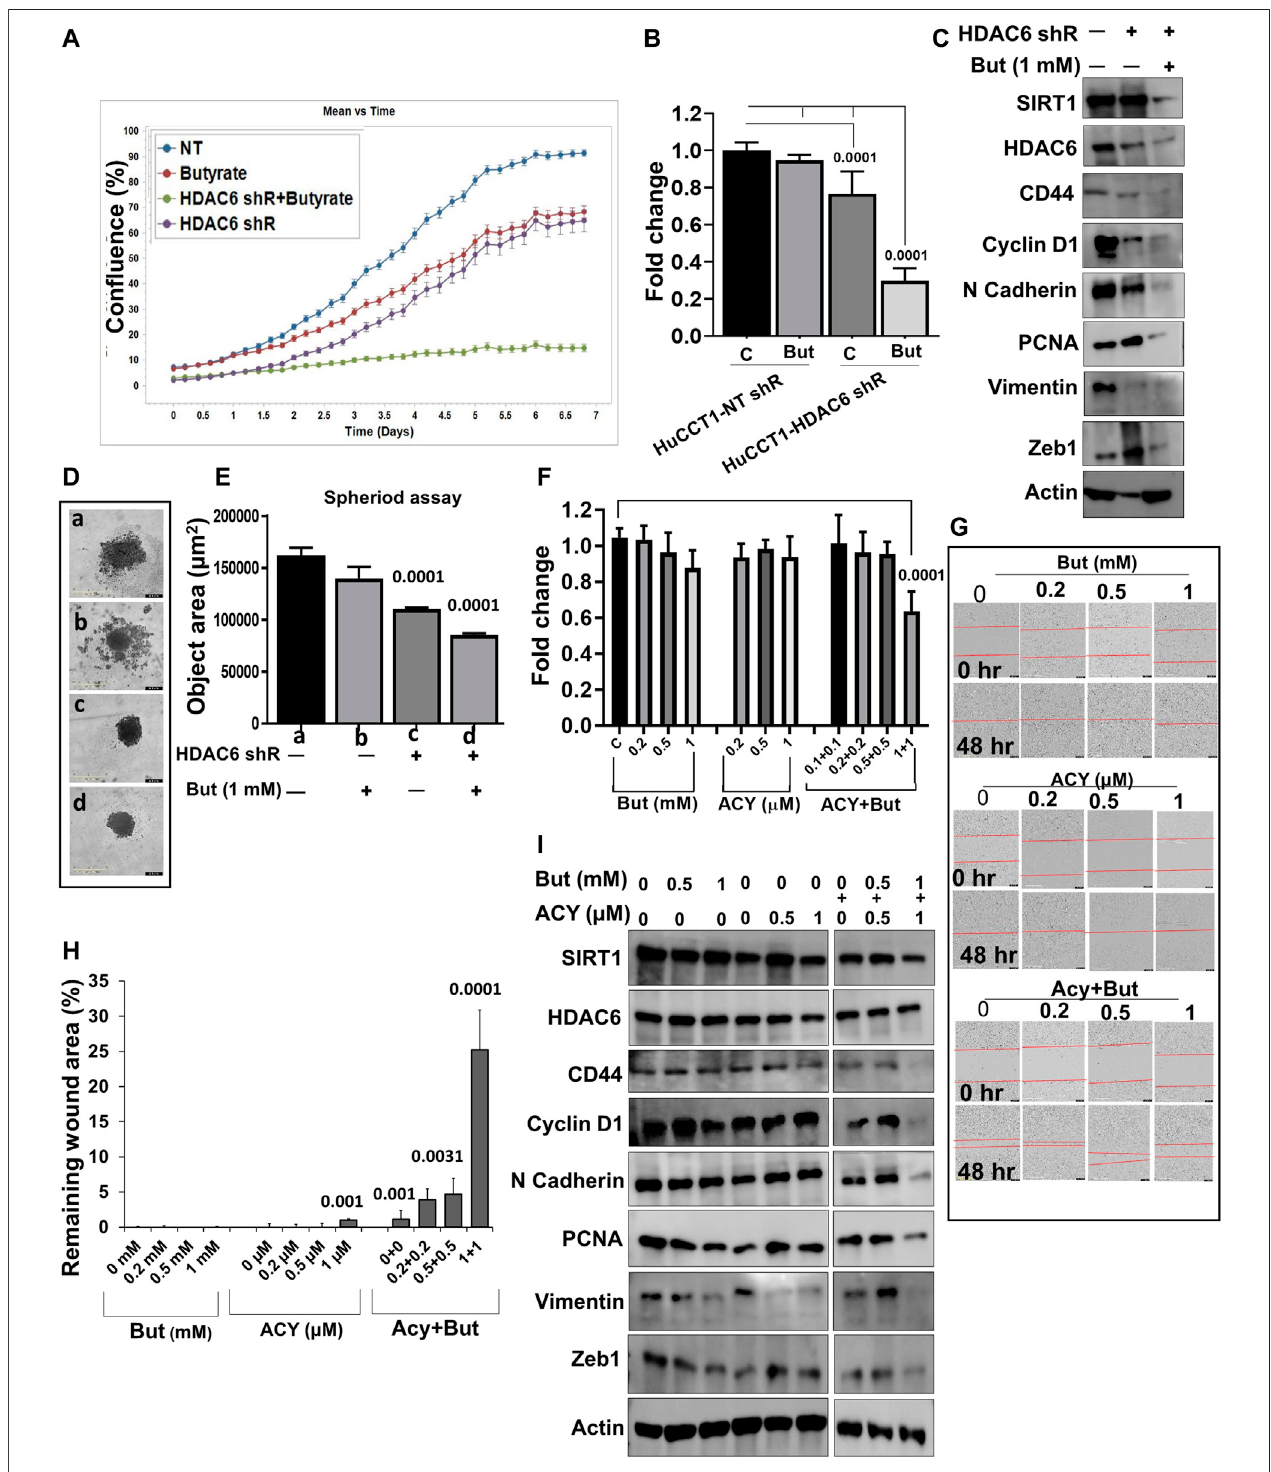
FIGURE3| ButyratepotentiatestheeffectoftheHDAC6inhibitors. (A) IncyCytecellproliferationassaywasdoneinHuCCT1cellstransfectedwithHDAC6shRNA andbutyrate(1 mM),andnon-targetshRNAwasusedasacontrol. (B) MTScellgrowthassaywasdoneinHuCCT1-HDAC6shRNAaloneorinthepresenceofbutyrate (1 mM). (C) Total cellular protein was isolated from HuCCT1 (NT, HDAC6-shR and HDAC6-shR + butyrate) cells and Western blots were performed for SIRT1, HDAC6, CD44, Cyclin D1, N-Cadherin, PCNA, Vimentin, Zeb1, and β -actin. (D, E) Spheroid assay was done using IncyCyte, and spheroid area was measured. (F) MTS